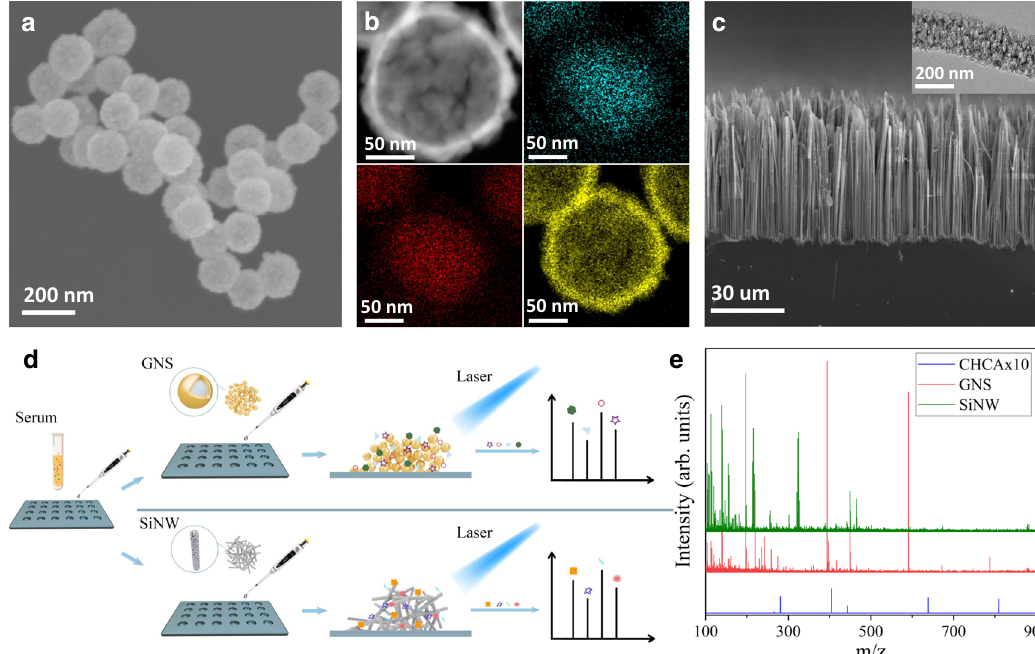
Fig. 1 Preparation of two nanomaterials for MNALCI. a Characterization of gold nanoshell (GNS): SEM showing relative uniform size distribution ~150 nm in diameter and the rough surface feature ( n ≥ 5 randomly selected). b TEM images ( n ≥ 3 randomly selected) and EDX analysis of the elemental distribution with O (azure), Si (red) and Au (yellow), proving the core-shell nanostructure. c Characterization of porous silicon nanowires: cross-section SEM image of the etched Si wafer showing high density nanowires forest ( n ≥ 5 randomly selected). (inset), TEM image showing highly porous nature of individual nanowires ( n ≥ 3 randomly selected). d Schematic of GNS and SiNW-assisted LDI measurement. e Comparison of typical LDI signals of a representative serum sample mixed with GNS, SiNW and